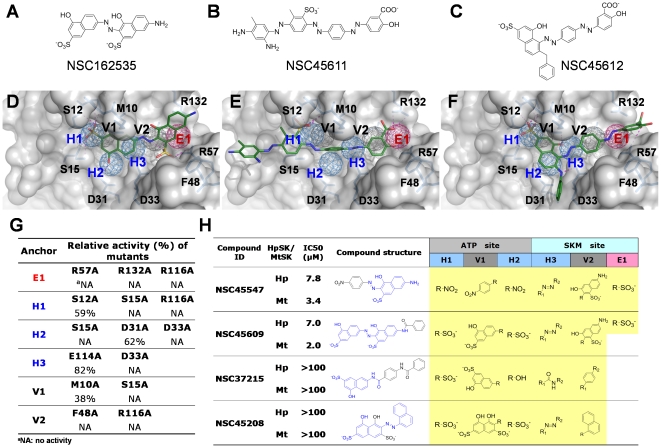
Characterization of shikimate kinase inhibitors by enzyme assay, CoreSiMMaps, site-mutagenesis studies, and analogues.(A–C) Structures of three inhibitors, NSC162535 (2), NSC45611 (1), and NSC45612 (3). (D–F) Relationships between anchors and docked mode of each inhibitor for HpSK. These compounds consistently include two negative charge moieties (SO3
− or CO2
−) that form hydrogen bonds with conserved interacting residues of anchors E1 and H1. (G) Comparison of relative activities of HpSK mutants. The conserved interacting residues for each anchor were mutated. R57, R132, R116, and F48 located in the shikimate site were critical for the enzymatic functions. (H) Potency of NSC162535 analogues. The substitution moieties of analogues are indicated in black. Those that lack the E1 moiety greatly lost the inhibitory effects (IC50>100 µM).